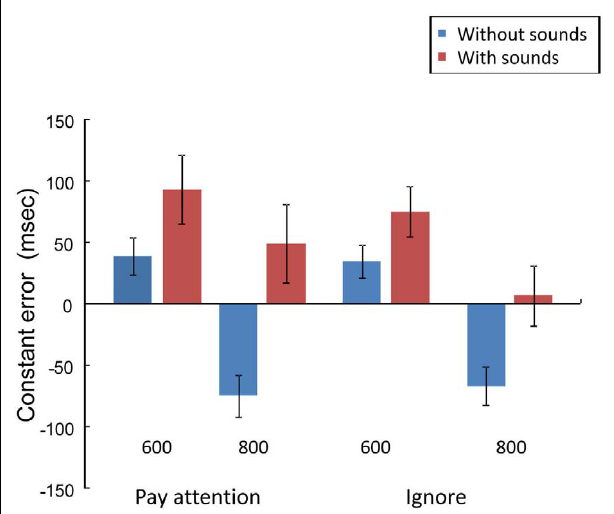
FIGURE 2 | Mean constant error (in ms) in the experimental conditions. Bars are